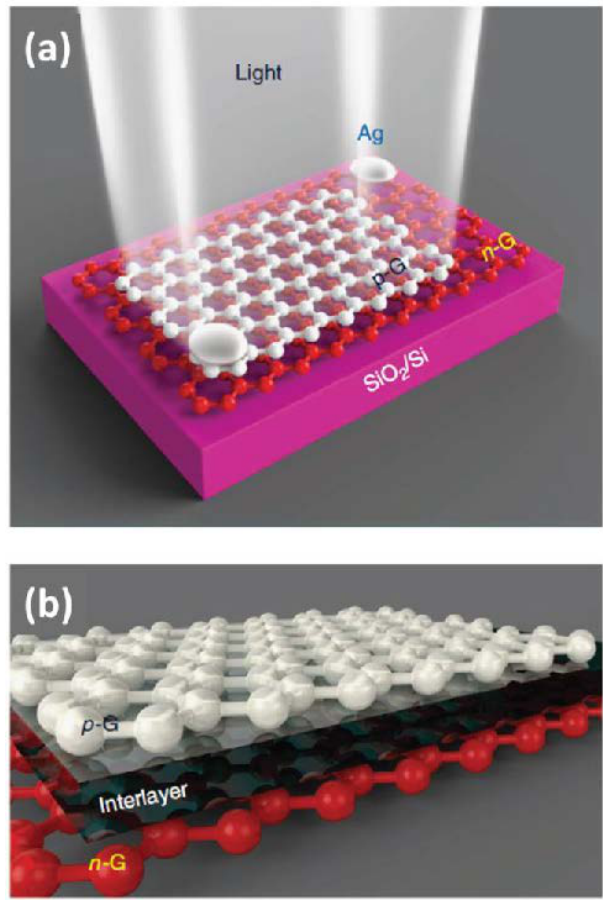
Figure 8: (a) A typical graphene p-n diode for photodetection and (b) its magnified version showing an interlayer between metallic p- and n-graphene (p-G and n-G) layers. For the electrodes, Ag was used. Figures with reprint permission from: (a) and (b) Ref. [176] ©2014 Macmillan Publishers